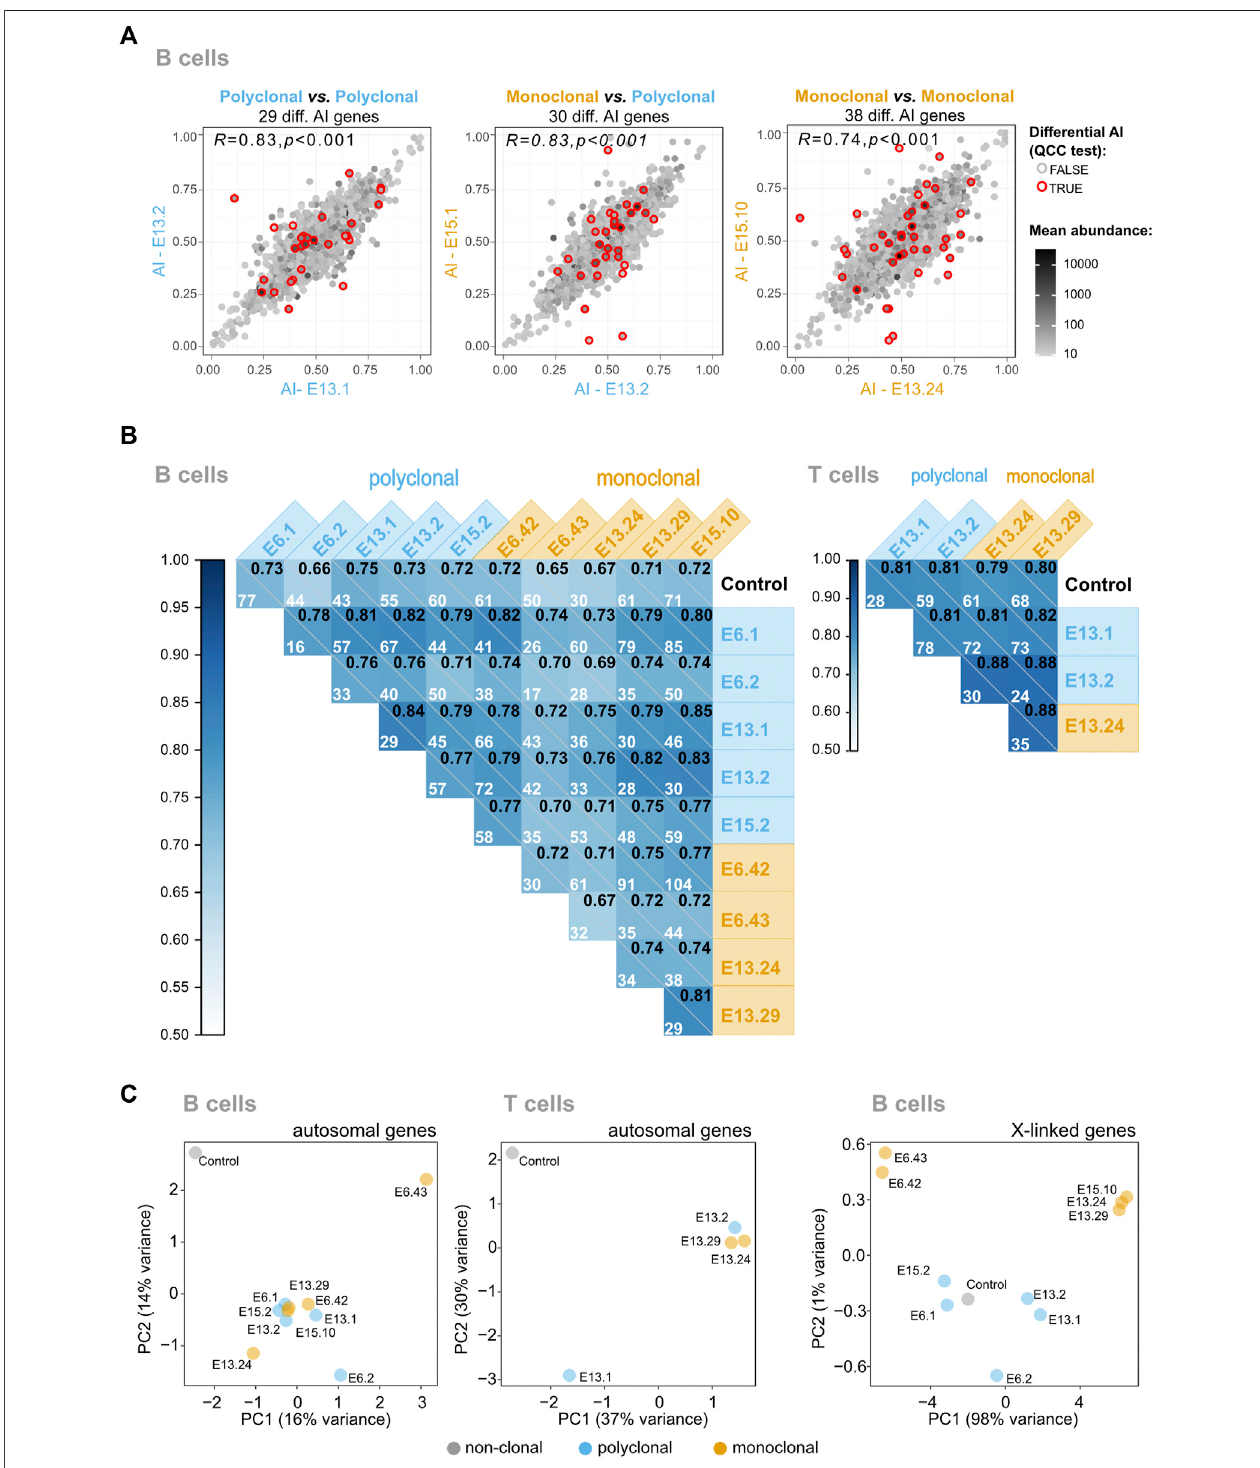
FIGURE 3 | The vast majority of mitotically stable allelic biases of the hematopoietic system are not established during the HSC stage. (A) Representative plots of pairwise AI comparisons (monoclonal vs. polyclonal samples, polyclonal vs. polyclonal samples; and monoclonal vs. monoclonal samples). Red circles signal the genes for which differential AI remained statistically signi fi cant after quality control constant (QCC) correction, and the total number of these genes per comparison is shown aboveeachplot.ThePearson ’ scoef fi cientcorrelationforallAIpairwisecomparisonsisalsoshown,intheupperleftcornerofeachdotplot.Agrayscalecoloringthe dots represents the mean expression between the two samples, calculated from each sample ’ s TMM-normalized counts. (B) Correlograms for B and T samples.